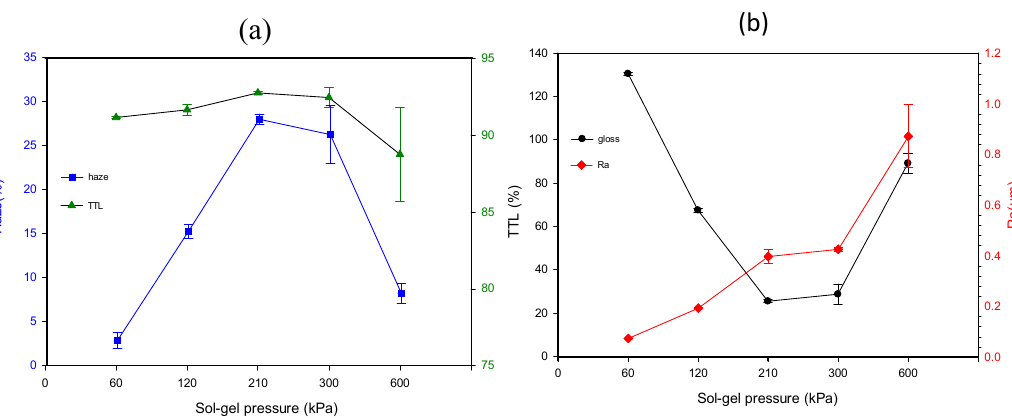
Figure 3. The influence of sol-gel deliver pressure on ( a ) TTL and haze ( b ) gloss and Ra with air transport pressure and displacement speed of 300 kPa and 300 mm/s, respectively.